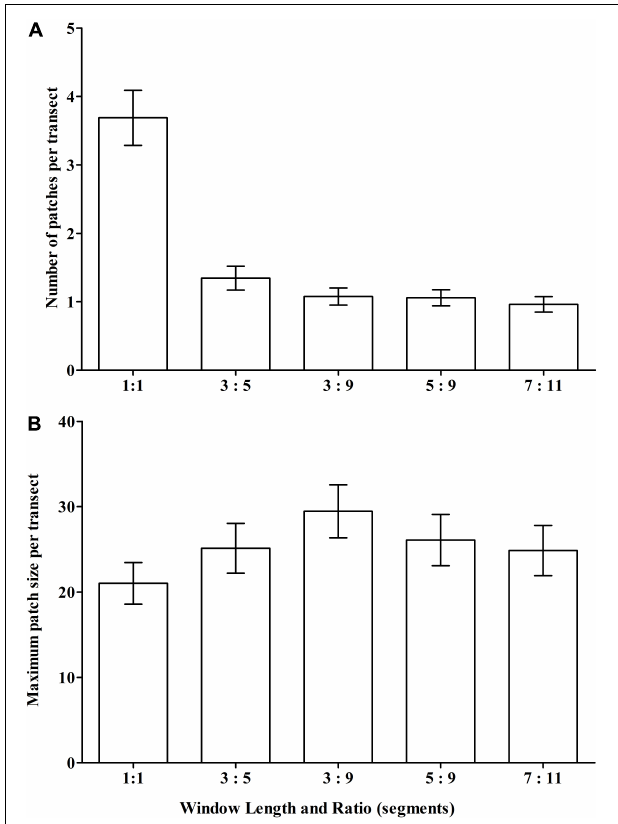
FIGURE 8 | Sensitivity of VME classification to changes in the length (number of segments) of the moving window and the ratio of VME habitat segments required within a window to identify contiguous patches with coral VME habitat status along transects. The effects of changing the moving window ratio from base-case (3:5) is compared to single segments (unsmoothed) and ratios of 3:9, 5:9 and 7:11 as measured across all transects in terms of changes to (A) the number of patches; and (B) the maximum patch length per